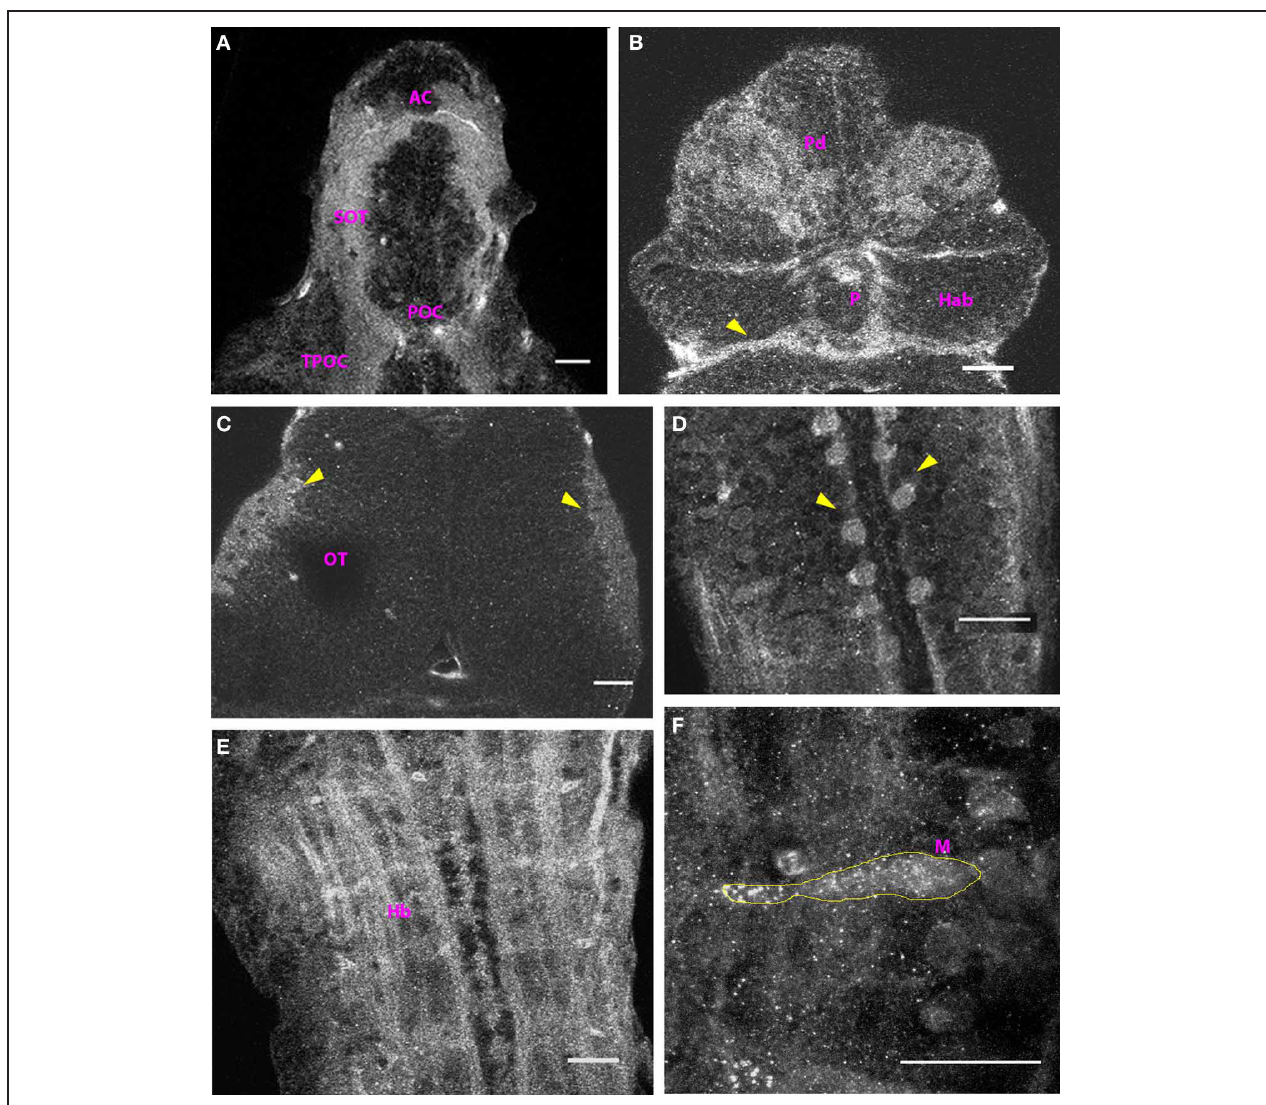
optic tectum (OT). A single optical section showing Cx35 immunoreactivity in the developing neuropil region (arrowheads). (D) Cell bodies (arrowheads) in hindbrain lining the rhombencephalic ventricle. (E) Ventral hindbrain (Hb) showing intense Cx35 immunoreactivity in fibers coursing through it. (F) Zoomed image of a Mauthner neuron (M, yellow outline) showing punctate Cx35 immunoreactivity. The image is a maximum intensity projection of optical slices collected from a 16 µ m thick tissue slice encompassing the Mauthner neuron. Scale bar for all panels: 20 µ m.